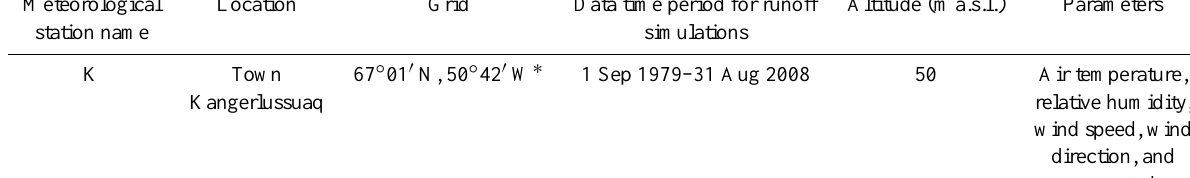
Table 1. Meteorological input data for the Kangerlussuaq simulations. Meteorological station data on the GrIS (S5, S6, and S9) were provided by Utrecht University, and coastal meteorological station data (K; Kangerlussuaq) by the Danish Meteorological Institute (DMI). For further information about the S-stations see e.g., van den Broeke et al. (2008a). Meteorological Location Grid Data time period for runoff Altitude